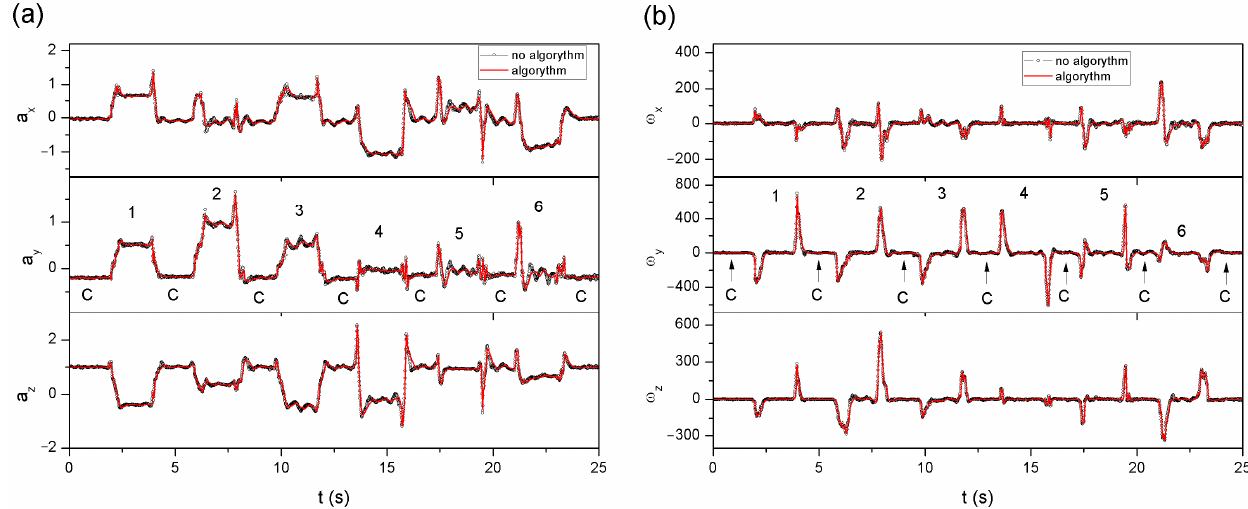
Figure 13. The first measurement series, consisting of six gestures (1–6) separated by the control gesture C, recorded from the sensor No. 8: ( a ) change in the values of individual components obtained from the accelerometer, ( b ) change in the values of individual components obtained from the gyroscope.